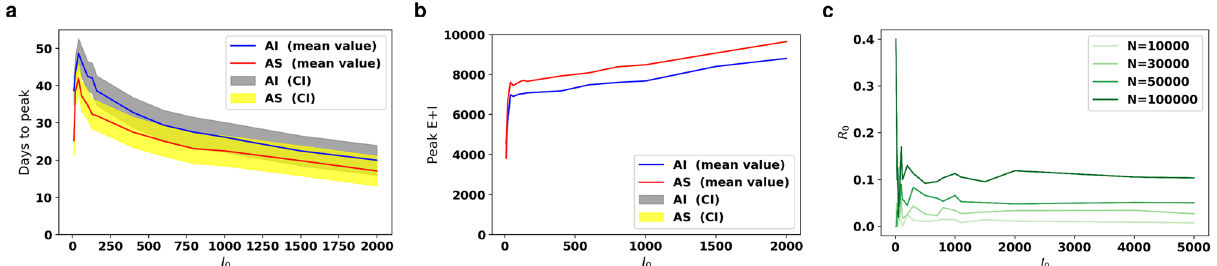
Figure 7. Sensitivity analysis of PanCitySim The number of initial infections ( I 0 ) was varied and the simulation was run 50 times using a subset of population(100,000 households). The mean plots for ( a ) number of days to peak and ( b ) size of peak are shown vs I 0 . We observe that higher number of initial infections results in bigger peaks which are achieved earlier. ( c ) shows a plot of of R 0 vs I 0 (for a fixed value of Θ � ). We observe that smaller values of I 0 result in a high stochasticity in the value of R 0 . This observation is valid for various sample size of individuals( N